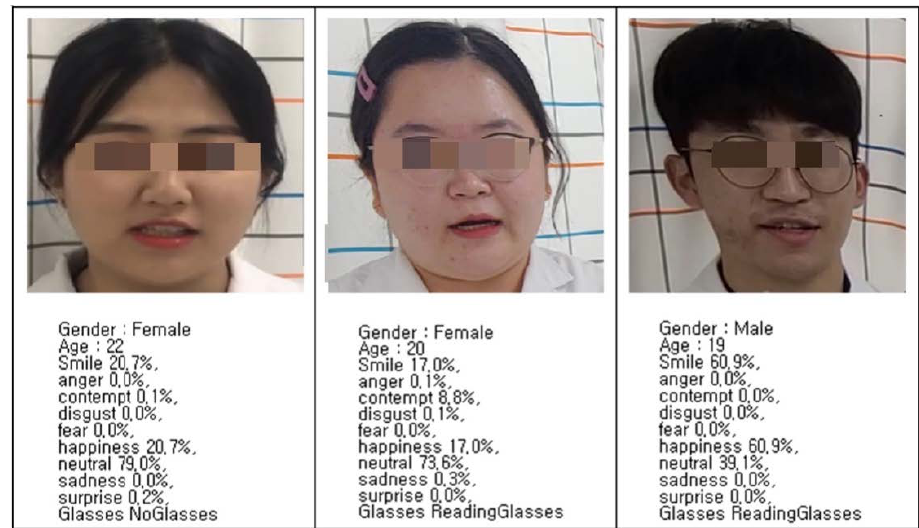
Figure 1. Example of facial expression analysis.